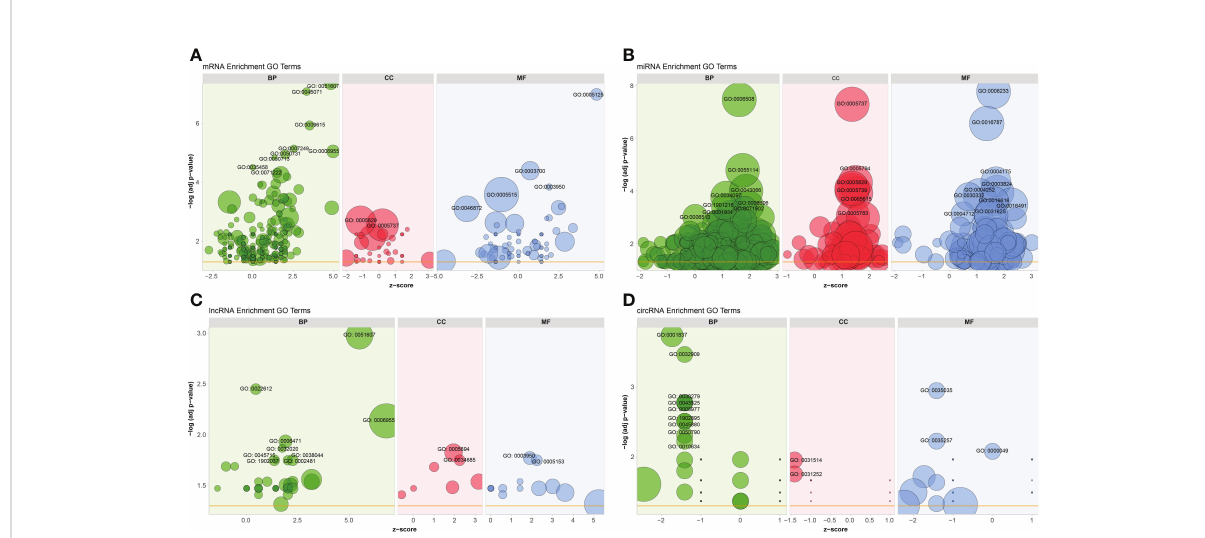
FIGURE 4 GO annotations of (A) dif-mRNAs, target mRNAs of (B) dif-miRNAs, (C) dif-lncRNAs, and (D) host mRNAs of dif-circRNAs under BP, CC, and MF ontologies, respectively. Z-score was equal to the total number of transcriptional increased dif-mRNAs minus the total number of decreased dif-mRNAs and then divided by the square root of the total number of dif-mRNAs in a certain GO term and was used to measure whether the term was upregulated or downregulated overall. The size of the solid circulars represented the number of enriched dif-mRNAs under speci fi c GO terms. GO: 0051607: defense response to virus, GO: 0045071: negative regulation of viral genome replication, GO: 0009615: response to virus, GO: 0007249: I-kappaB kinase/NF-kappaB signaling, GO: 0006955: immune response, GO: 0050731: positive regulation of peptidyl- tyrosine phosphorylation; GO: 0050713: negative regulation of interleukin-1 beta secretion, GO: 0035458: cellular response to interferon-beta, GO: 0071222: cellular response to lipopolysaccharide, GO: 0005829: cytosol, GO: 0005737: cytoplasm, GO: 0005125: cytokine activity,